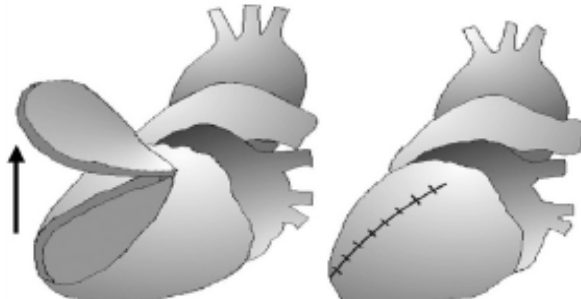
Fig. 1 – Partial left ventriculectomy